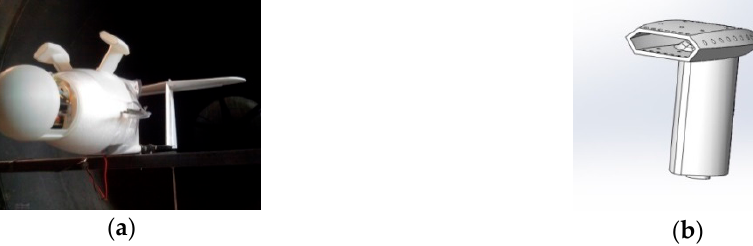
Figure 4. The hoods where the temperature and humidity sensors are placed: ( a ) hoods installed on the top of OVLI-TA fuselage; and ( b ) 3D design of the hoods.